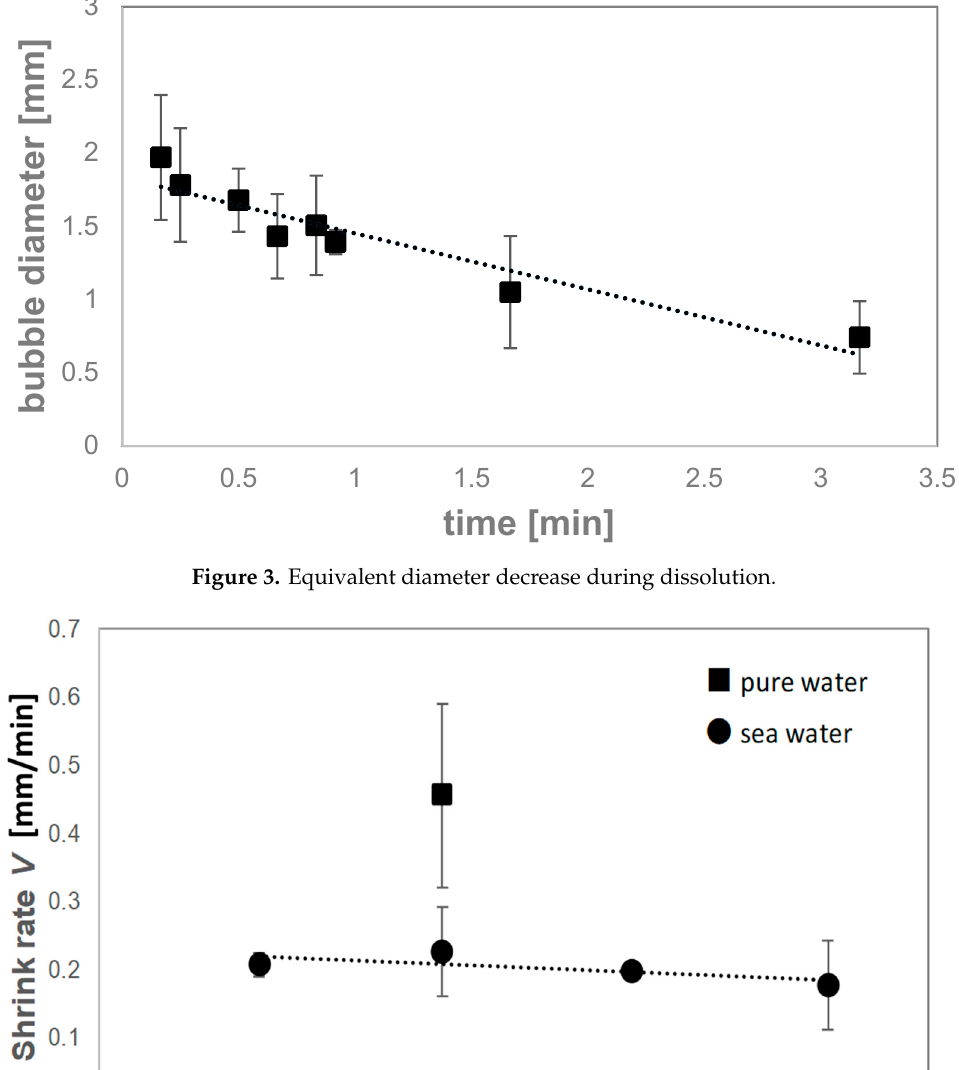
Figure 3. Equivalent diameter decrease during dissolution.